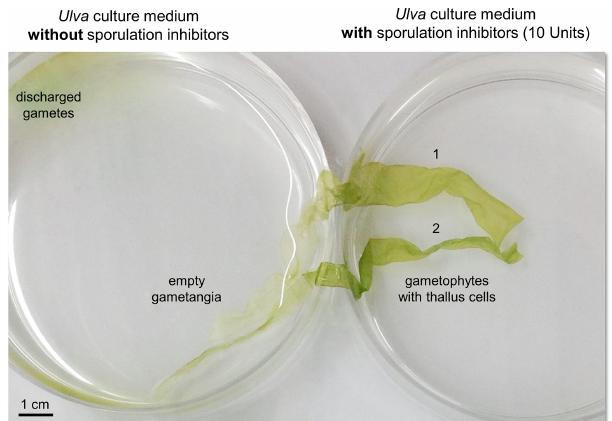
Figure 1. Inhibition of gametogenesis by an externally supplied sporulation inhibitor (SI-1). Two thalli (1 and 2) were transferred into fresh UCM distributed over two Petri dishes. Mature game- tophytes undergo gametogenesis upon removal of SIs by washing the thalli. Within three days, gametes were formed and released on the third day after induction (left). The addition of 10 units of SI-1 inhibited the differentiation of thallus cells into gametangia (right) (see Supplement for detailed method description according to Kessler et al.,